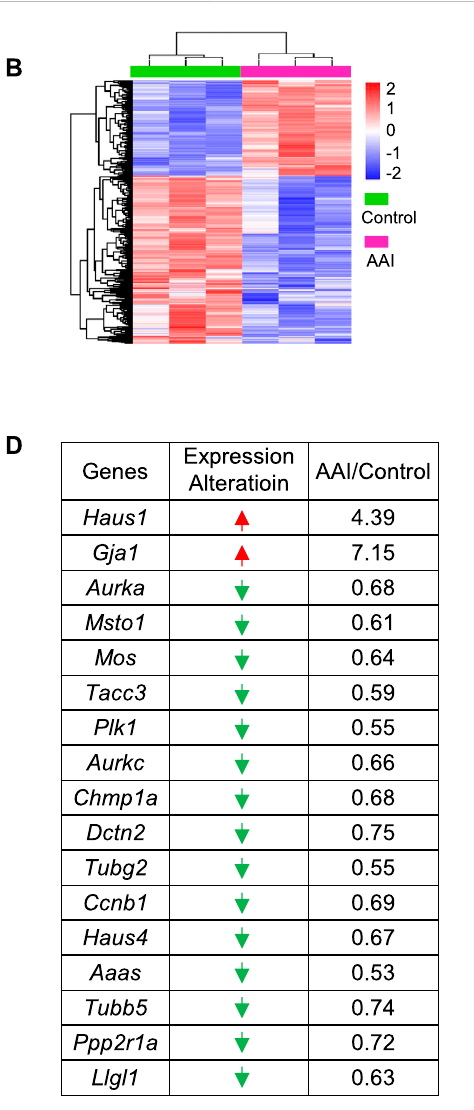
signi fi cantly more proportions of oocytes with aberrantly organized spindles including nonpolar, unipolar, and multipolar spindles (Figures 4A,B). Consistent with the dosage-dependent effect of AAI on chromosome mis- segregation (aneuploidy) (Figures 3A,B), the proportion of oocytes bearing aberrant spindles signi fi cantly increased with increasing concentrations of AAI exposure (0 μ M: 19.44%; Moreover, a dosage-dependent effect of AAI exposure on